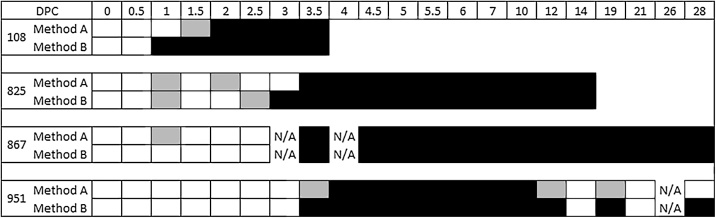
Comparison of both methods tested with experimental whole milk samples. Each square represents the average CT value of the whole milk sample at each day post contact. White squares represent a ‘No CT’ value – no detection. Black squares represent any CT value including or below 45 (Method A) or 50 (Method B) in all replicate wells – FMDV positive. Grey squares represent instances where a ‘No CT’ value was observed in one or two wells, but a positive result was observed in the other replicates. N/A represents where there was not sufficient sample available for testing.